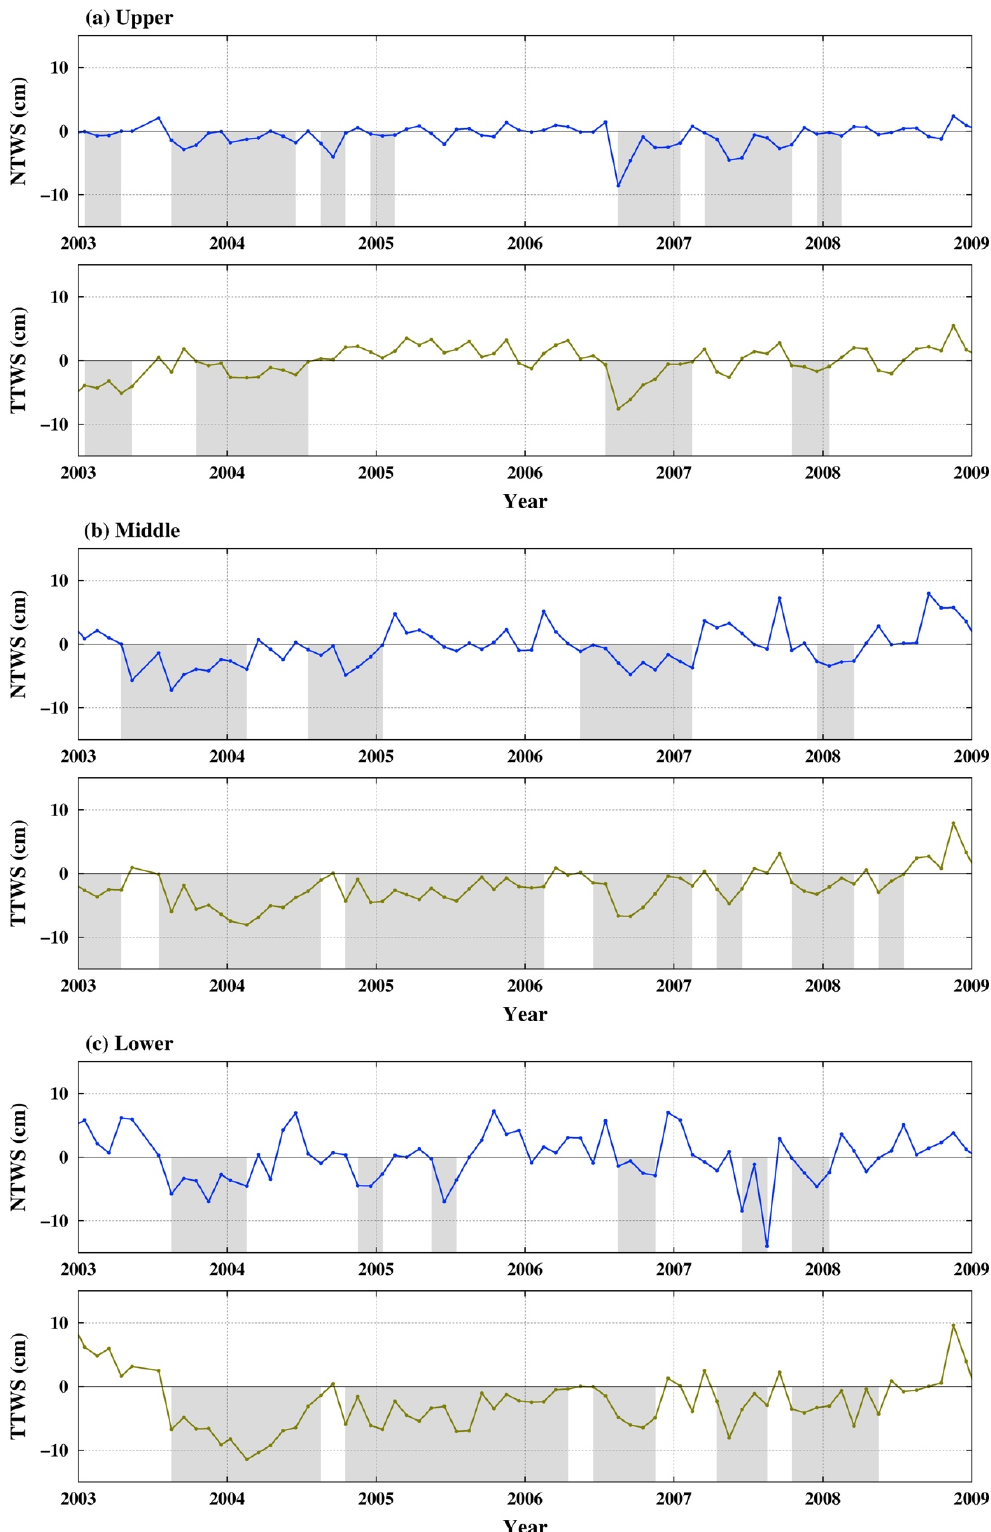
Figure 7. Hydrological drought signals from 2003 to 2008 in the ( a ) upper, ( b ) middle, and ( c ) lower sub-basins. The hydrological drought signals were obtained by removing the annual and seasonal cycles from the TTWS and the NTWS time series. The blue and green lines represent hydrological drought signals from the NTWS and TTWS time series, respectively, and the dark areas indicate hydrological drought events.